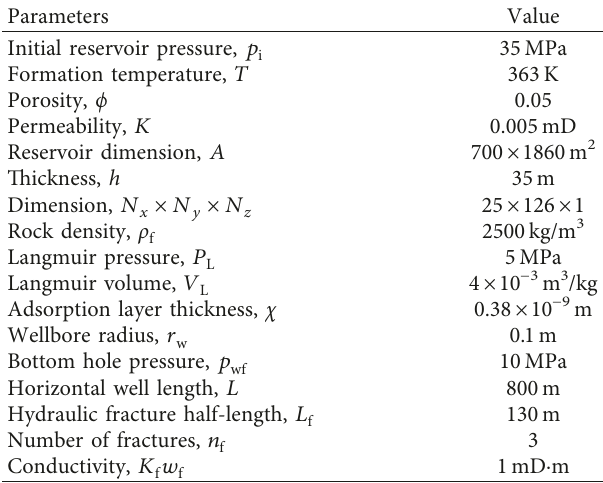
Figure 11: The relationship between permeability correction coefficient and pressure: (a) without stress sensitivity; (b) with stress sensitivity. Table 4: Main parameters for gas reservoir